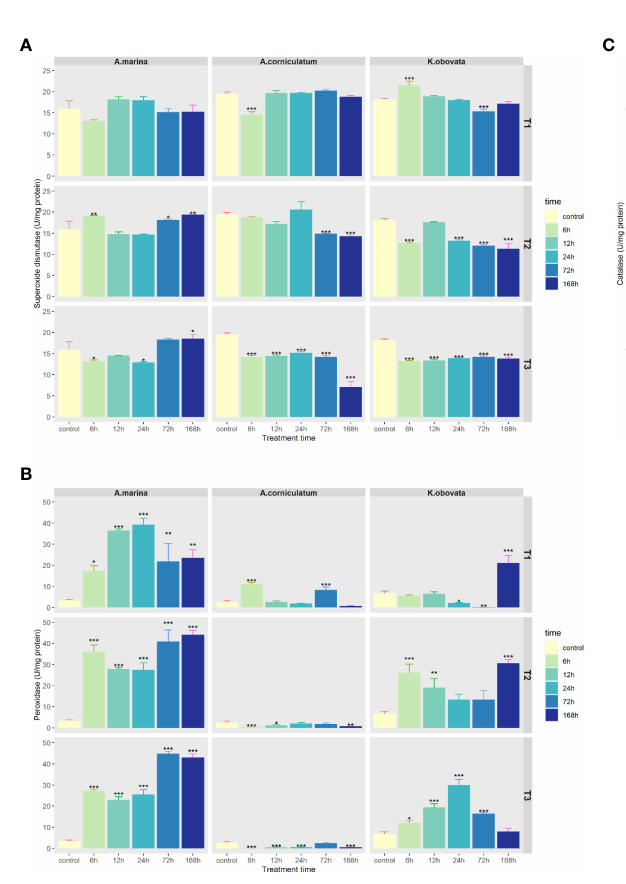
FIGURE 4 Changes of (A) Superoxide dismutase, (B) Peroxidase and (C) Catalase activities under upwelling stress. * indicates that there are signi fi cant differences between control and treatment groups (p<0.05(*), p<0.01(**), p<0.001(***)). “ T1 ” means 5°C upwelling stress, “ T2 ” means 10°C upwelling stress and “ T3 ” means 15°C upwelling